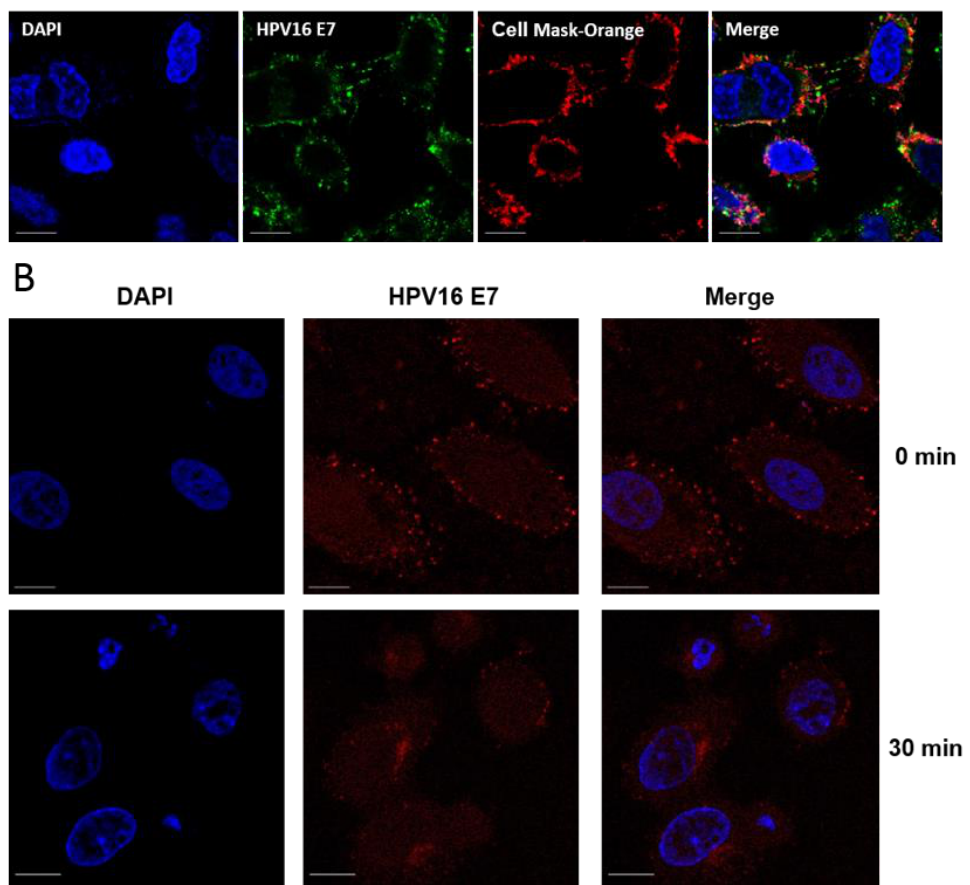
Figure 3. ( A ) Co-distribution of E7 with the cell membrane marker CellMask Orange (red) in unpermeabilised SiHa cells. Live cells were dual-stained with anti-E7 (Abcam) and CellMask Orange; ( B ) Time and temperature-dependent internalisation of cell surface E7, chased by anti-E7 antibody (Abcam). SiHa cells were incubated with the anti-E7 antibody for 1 h at 4 °C and incubated at 37 °C for 30 min to allow E7 internalisation. Cells were fixed, permeabilised and stained with AlexaFluor568 anti-mouse antibodies. Fluorescent imaging was performed using either a Zeiss LSM700 or LSM510 inverted microscope. The scale bar = 10 µm.